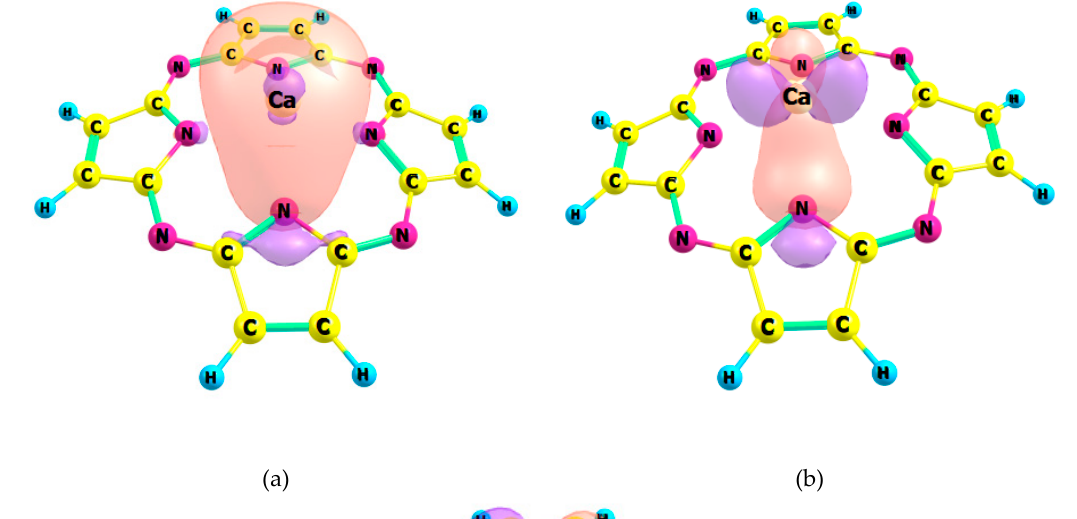
Figure 2. Schemes of the dominant donor-acceptor interactions between Zn and Pz ligand: ( a ) the result of the orbital interaction of the type LP(N) → 4 s (Zn) (E (2) = 54.0 kcal mol − 1 ); ( b ) the result of the orbital interaction of the type LP(N) → 4 p (Zn) (E (2) = 61.9 kcal mol − 1 ). Only one of the four corresponding interactions is demonstrated.